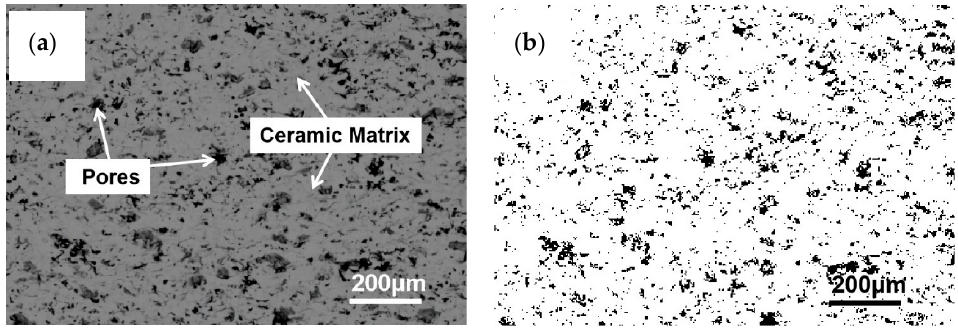
Figure 1. SEM image of the YSZ coating: ( a ) original, ( b ) Binarized.